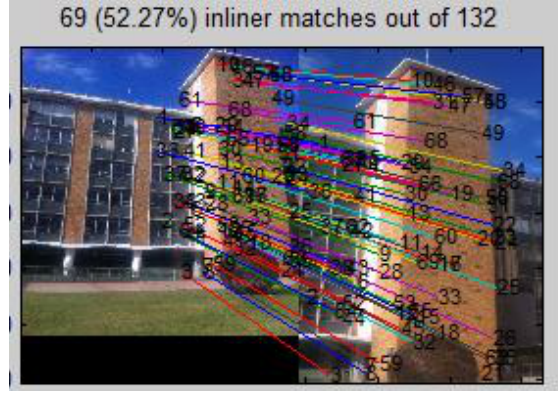
Figure 11. SIFT based matching between query image and the 2nd ranked reference image No. 15 with mismatches removed by RANSAC; Average correlation coefficient score = 0.84.